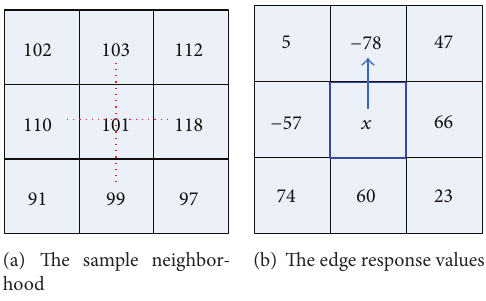
Figure 3: A sample neighborhood and its edge response